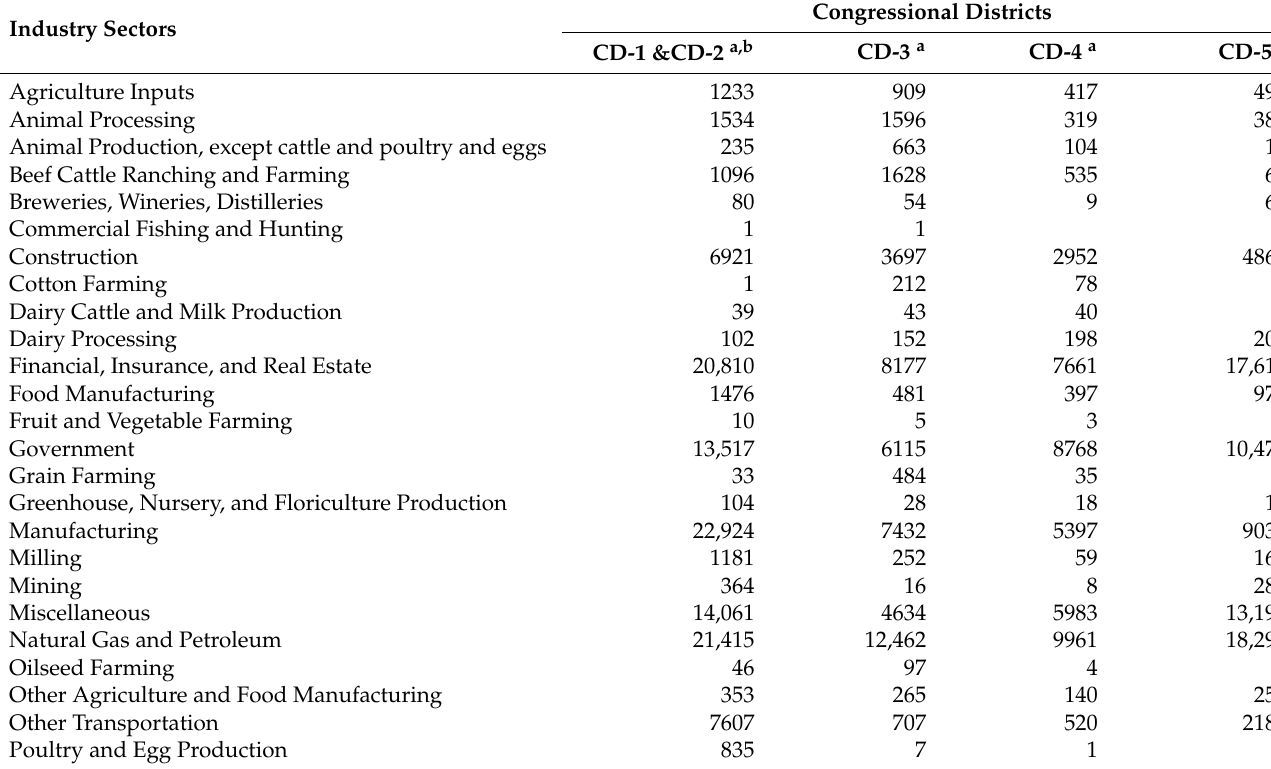
Table 1. Oklahoma 2019 Total Industrial Output (TIO) by Industry Sector and Congressional districts ($